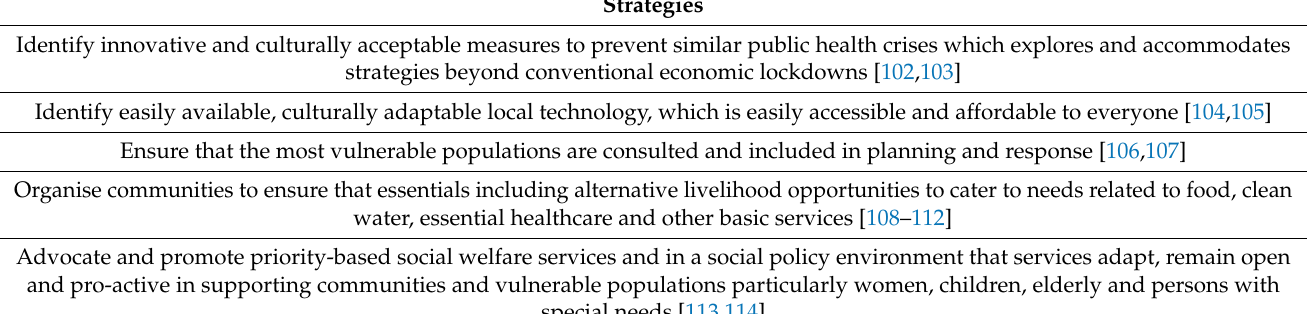
Table 3. Strategies for COVID-19 and